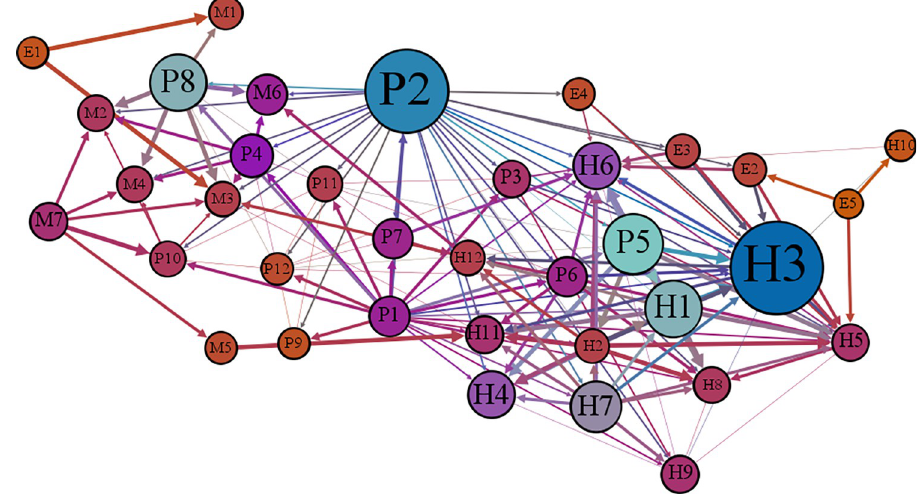
Fig 4. Network structure diagram of the factors that cause lifting